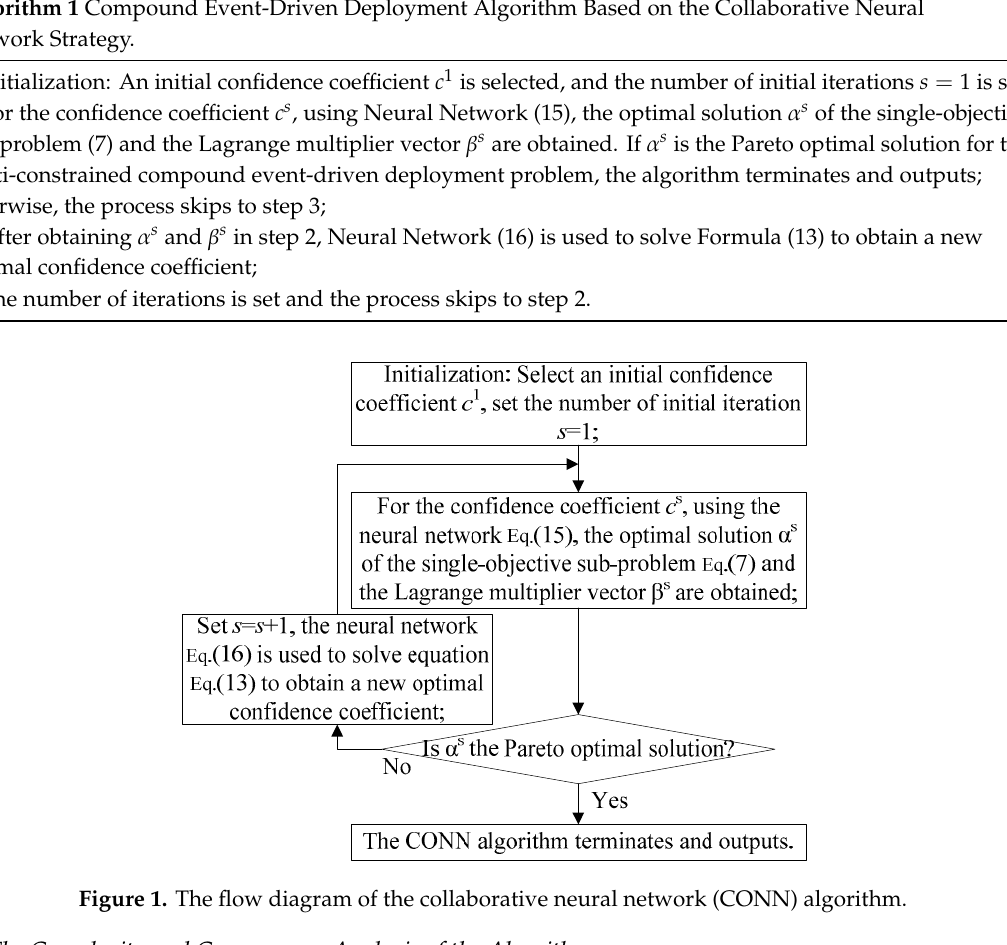
Algorithm 1 Compound Event-Driven Deployment Algorithm Based on the Collaborative Neural Network Strategy.